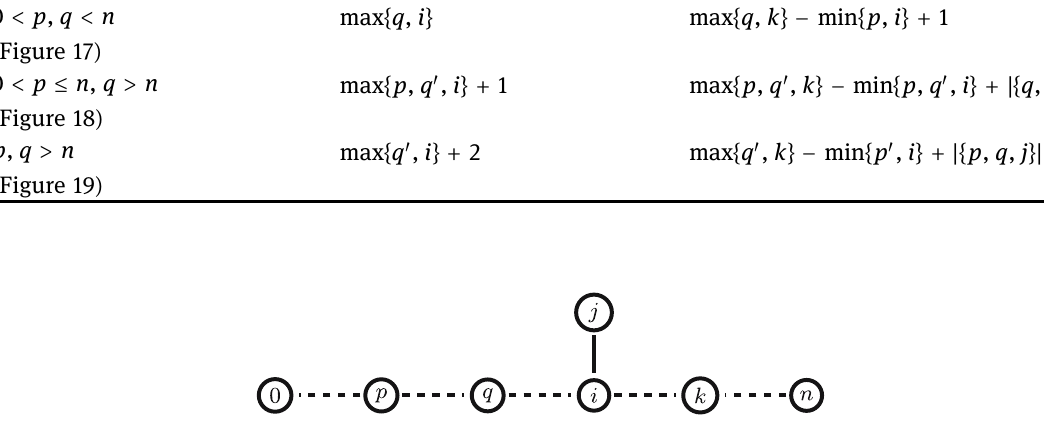
Figure 17: Minimum subgraph of C containing vertices {